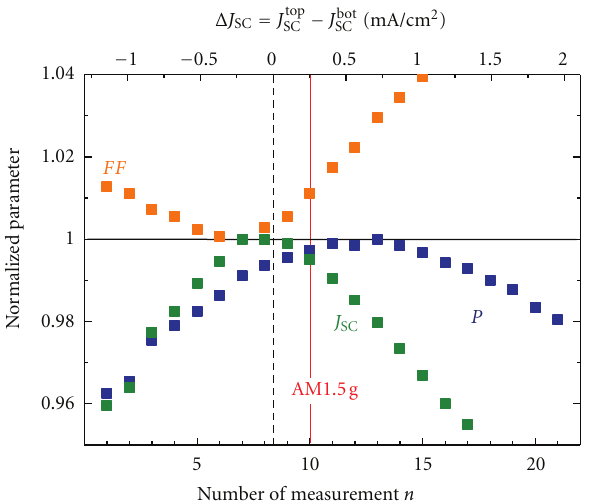
top bot and of the subcells. Additionally, SC SC 𝐽𝐽𝐽𝐽 𝐽𝐽𝐽𝐽